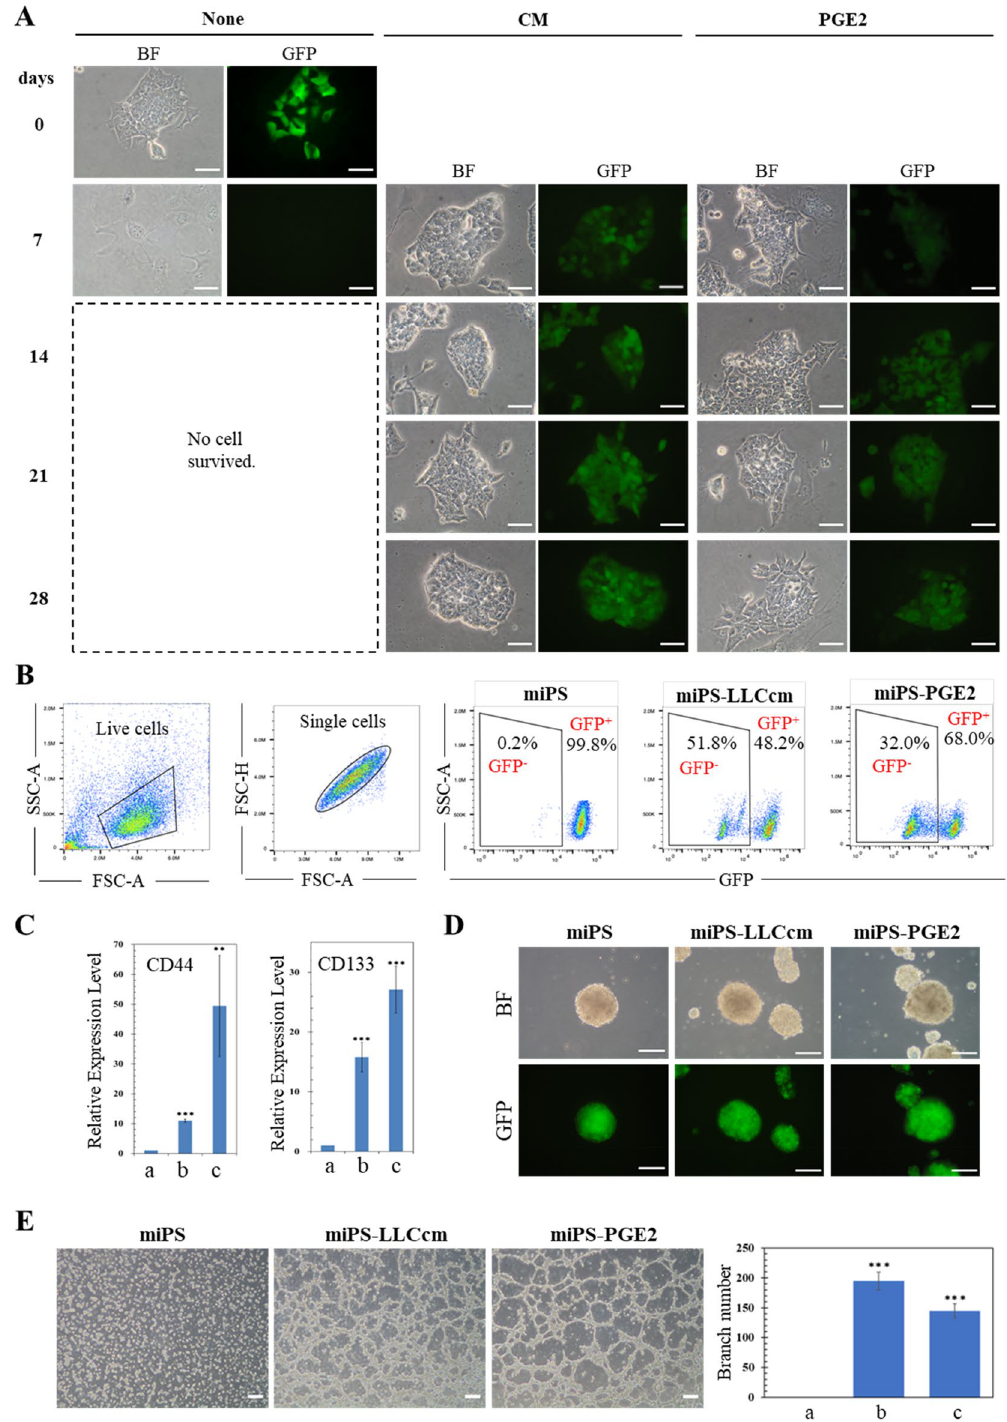
Figure 2. Evaluation of the effect of PGE2 on miPSCs. ( A ) Time course change of morphology during 4 weeks of treatment. The images of the cells before treatment are put at the left as the control of the start point with GFP positive cells. BF, bright field; GFP, green fluorescence. Scale bar 50 µm. ( B ) Flow cytometric analysis for the GFP + population in miPSCs, miPS-LLCcm cells and miPS-PGE2 cells. ( C ) Comparison of the expression of CD44 and CD133 between miPSCs, miPS-LLCcm cells and miPS-PGE2 cells by RT-qPCR. a: miPSCs, b: miPS- LLCcm, c: miPS-PGE2. Data are plotted as means ± SD. * p < 0.1, ** p < 0.05, *** p < 0.01. ( D ) Comparison of the sphere formation of miPSCs, miPS-LLCcm cells and miPS-PGE2 cells. Scale bar 200 µm. ( E ) Tube formation assay on miPSCs, miPS-LLCcm cells and miPS-PGE2 cells (left). Scale bar 200 µm. Branching point analysis by ImageJ (right). a: miPS, b: miPS-LLCcm, c: miPS-PGE2. Data are plotted as means ± SD. *** p <